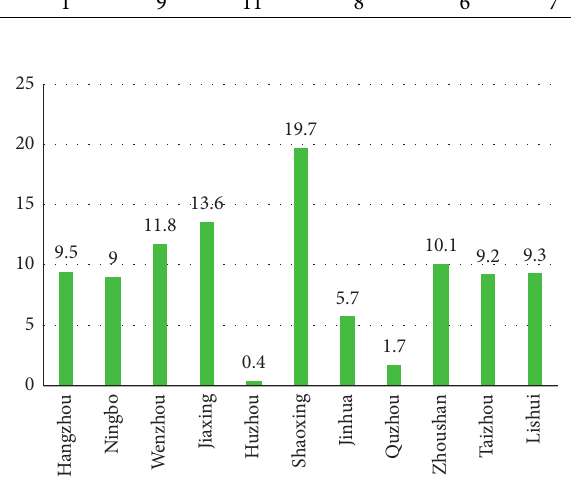
Figure 7: Contribution rate of each prefecture